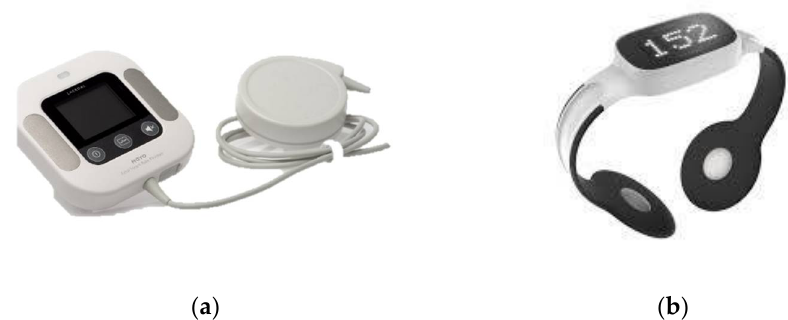
Figure 1. Moyo fetal heart rate monitor ( a ) and NeoBeat heart rate meter ( b ).